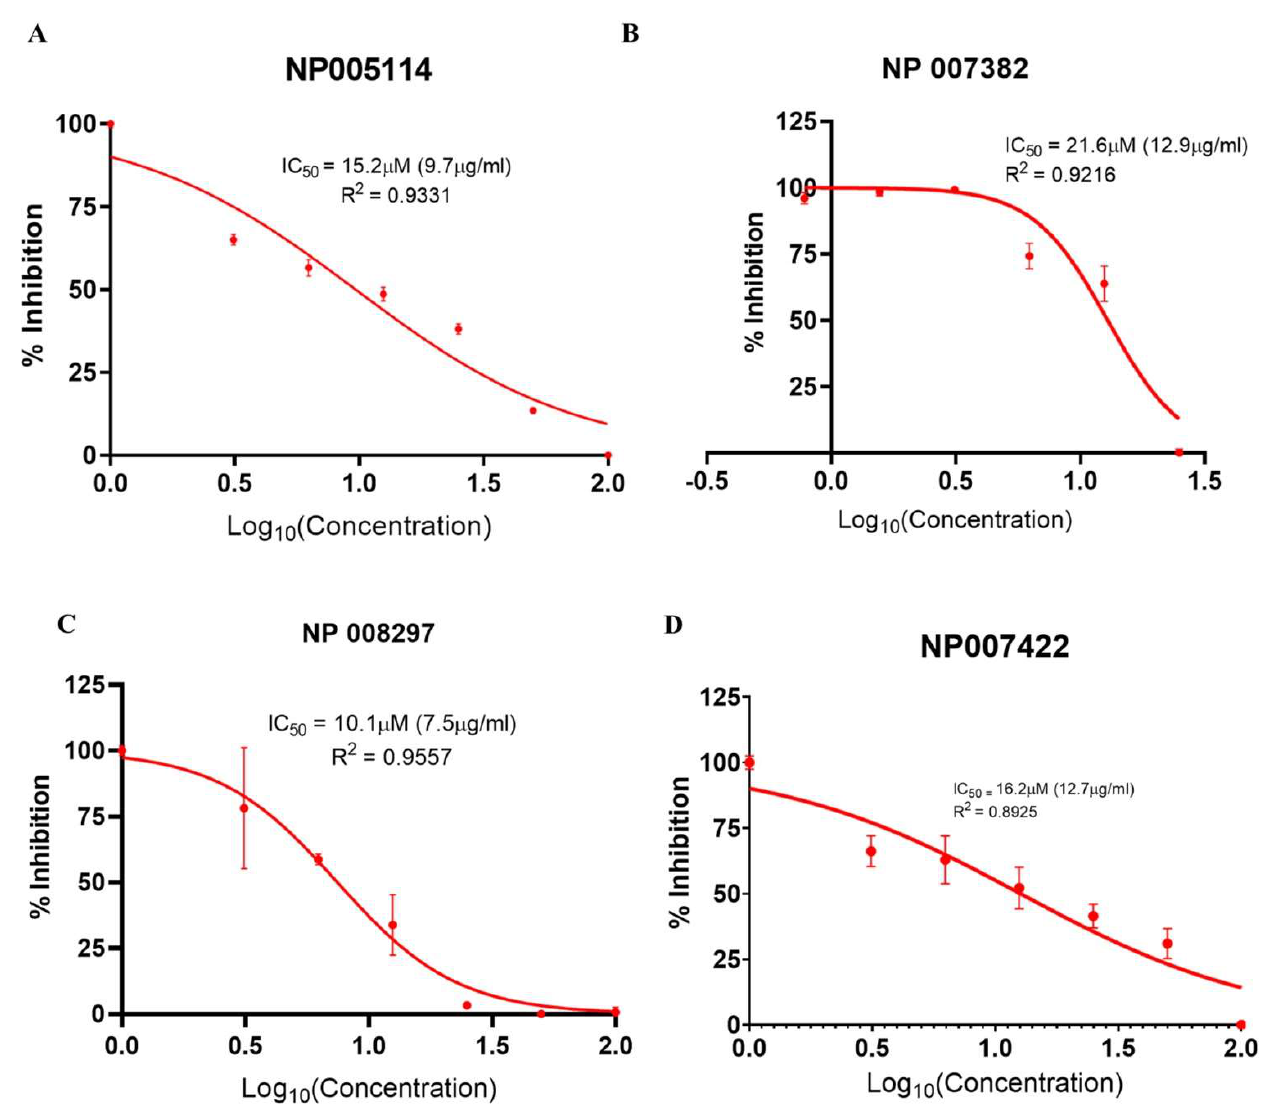
Figure 7. Cell-based viral infectivity inhibition assay. Nonlinear regression plot of percentage inhibition (response) against the Log 10 of compound concentration (dose) at a 95% confidence interval. ( A ) NP-005114 had IC 50 of 15.2 µ M (9.7 µ g/mL), ( B ) NP-007382 had IC 50 of 21.6 µ M (12.9 µ g/mL), ( C ) NP-008297 had IC 50 of 10.1 µ M (7.5 µ g/mL), and ( D ) NP-007422 had IC 50 of 16.2 µ M (12.7 µ g/mL). Error bars represent the standard error of the mean (SEM) of triplicate